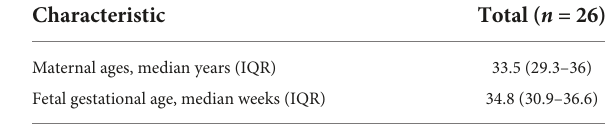
TABLE 1 Maternal ages and fetal gestational